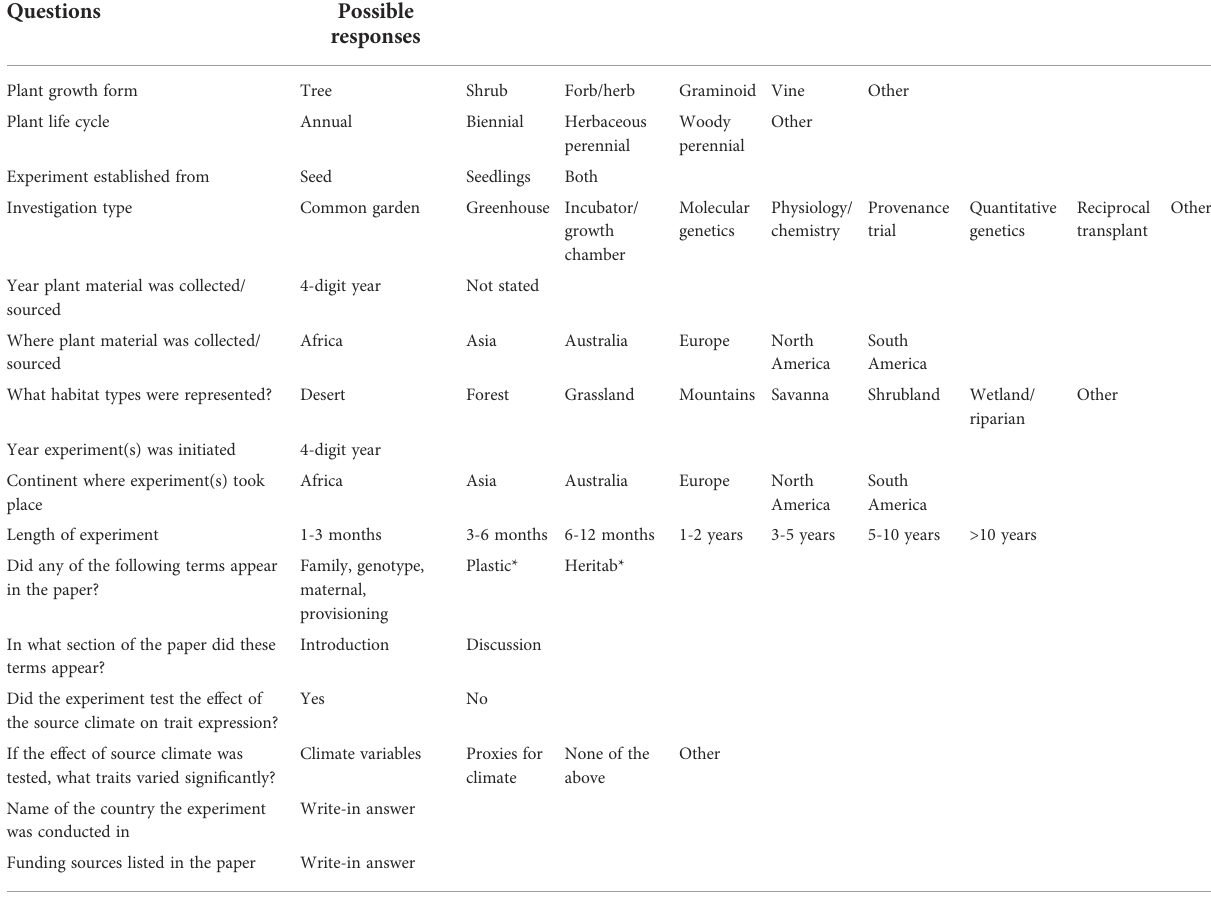
TABLE 1 Terms or concepts considered during the review, with their associated multiple-choice responses.